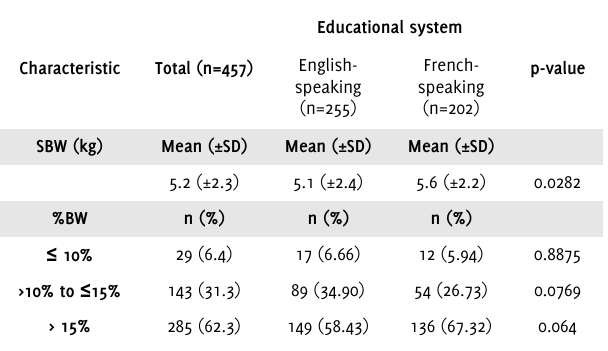
Table 2 . Distribution of school children by schoolbag weight as percentage of body weight